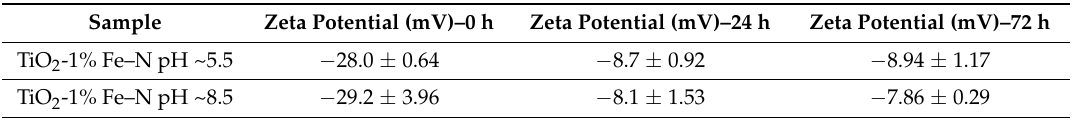
Table 5. The zeta potential values measured over time for particle dispersions prepared in cell culture media.